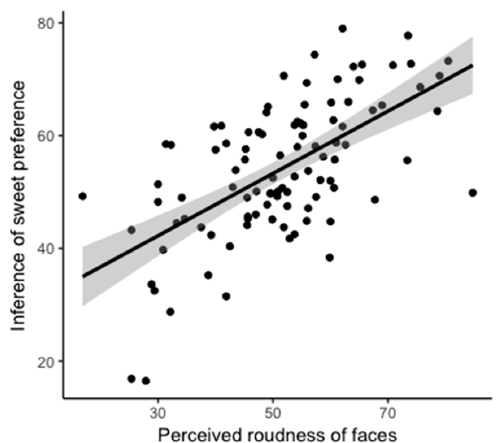
Figure 7. Scatterplots show correlations between the perceived roundness of faces and inferences about preferences for sweet foods. The dots were derived from the mean value of each condition (round, angular, and neutral) for each participant. This graph is for illustration purposes only, as